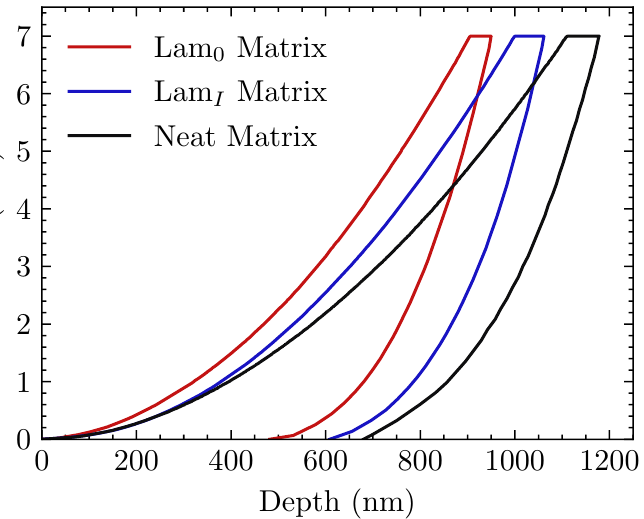
Figure 9. Representative load–depth nanoindentation curves for each matrix. Ex-situ curve on the neat matrix is provided for